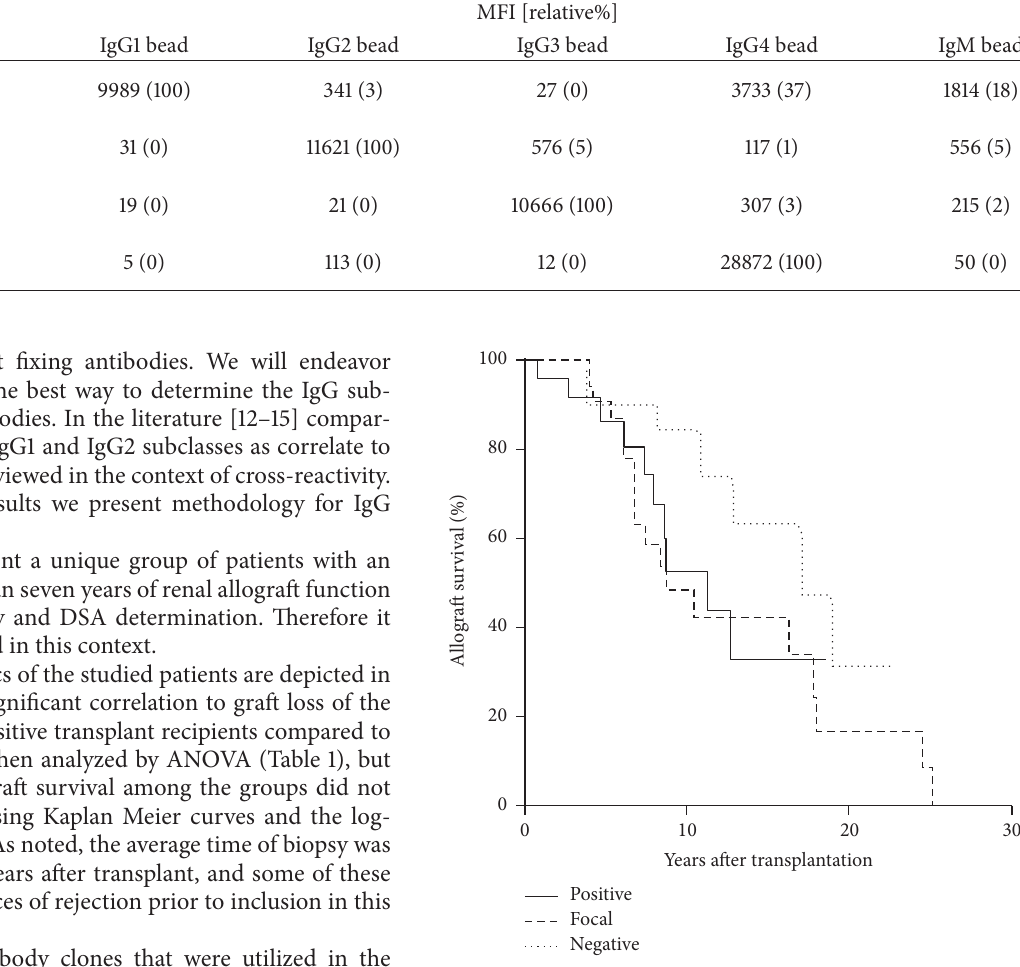
Figure 1: Comparison of renal allograft survival among study patients. The three cohorts of patients are separated according to the results of their with renal biopsies: diffusely positive C4d immunostaining (Positive), focally positive C4d immunostaining (Focal), and negative C4d immunostaining (Negative). The log-rank test result for the Kaplan Meier curves is